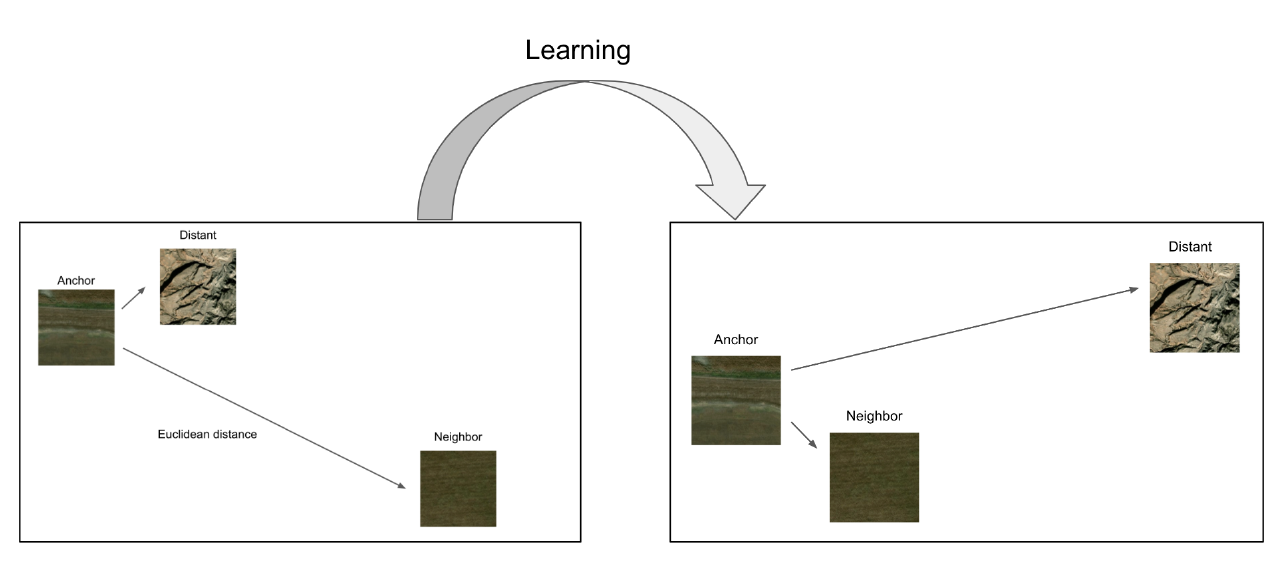
Figure 2. On the left, the model inaccurately characterizes the Euclidean distance between the learned representations of the anchor image and neighbor and distant images. Through unsupervised triplet loss, the model learns to minimize the distance between the representations of the anchor and neighbor images and maximize the distance between the representations of the anchor and distant images, as shown on the